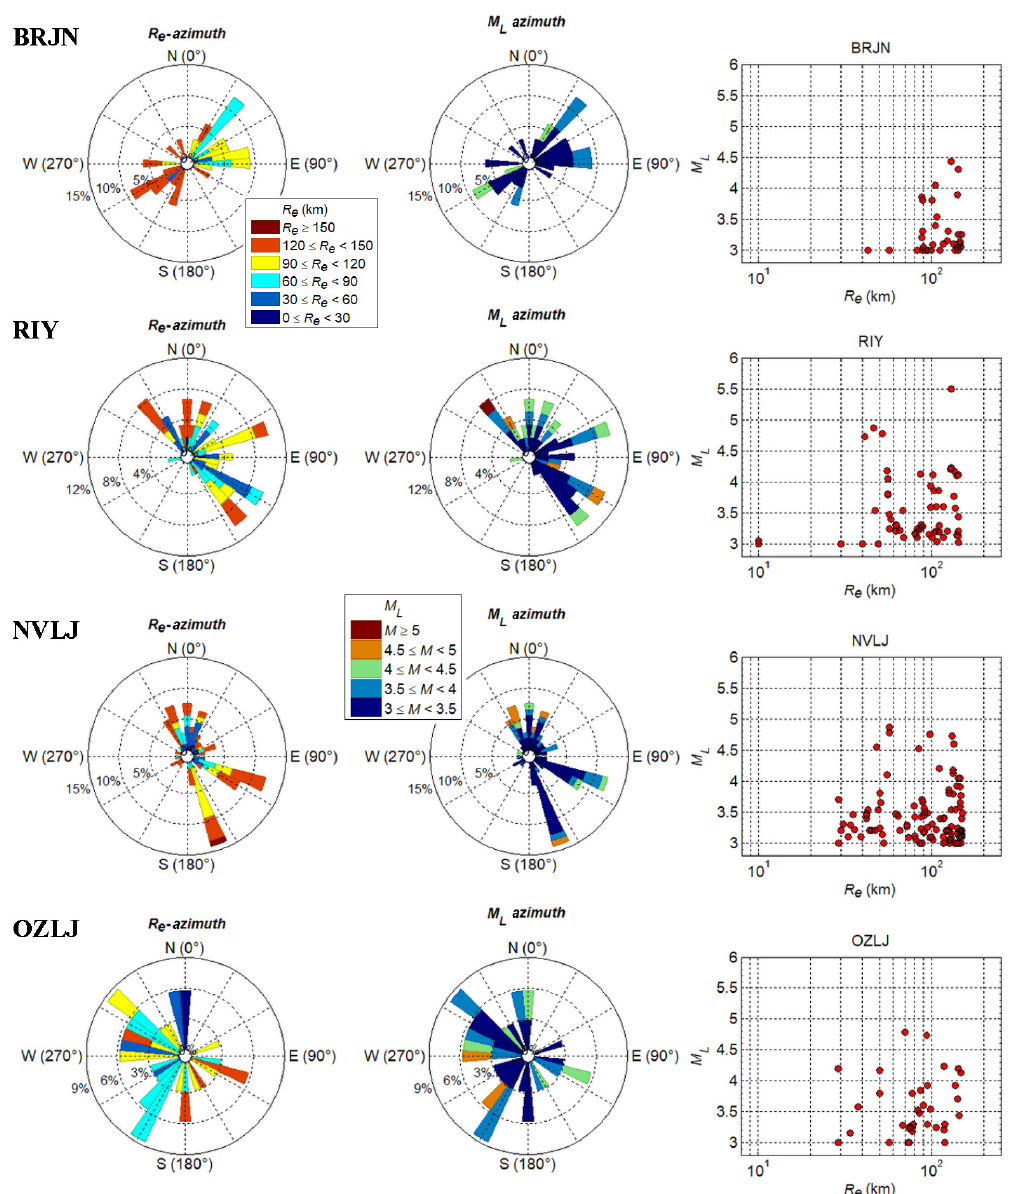
Figure 4. Statistics of the compiled ground-motion dataset. Left panels: azimuthal distribution of R e . Middle panels: azimuthal distribution of M L . Right panels: R e − M L distribution of recordings at each